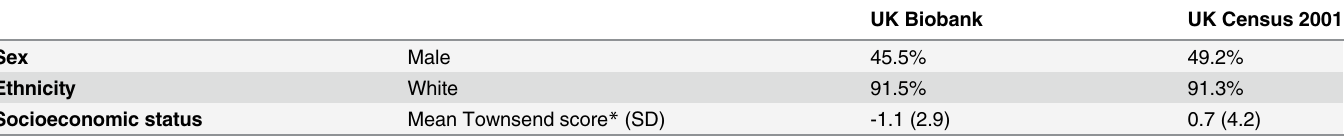
* Lower Townsend scores indicate less deprivation. Sex and ethnicity are shown as percentages while socio-economic status is reported as average Townsend deprivation index score (with standard deviation).